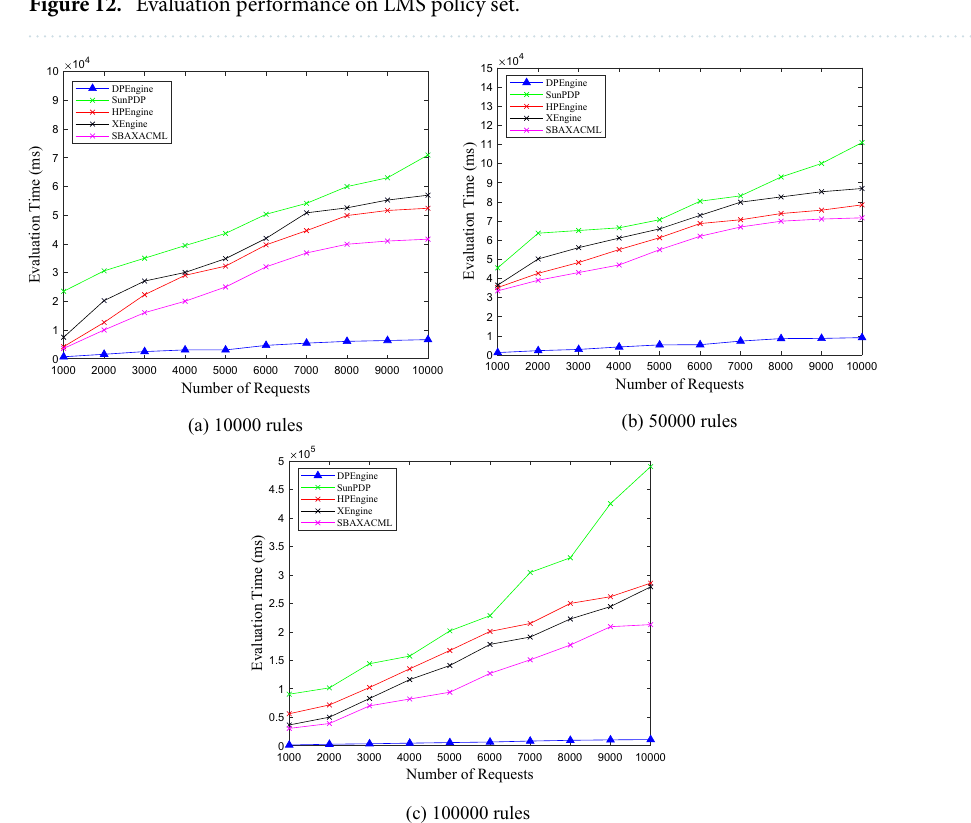
Figure 13. Evaluation performance on VMS policy